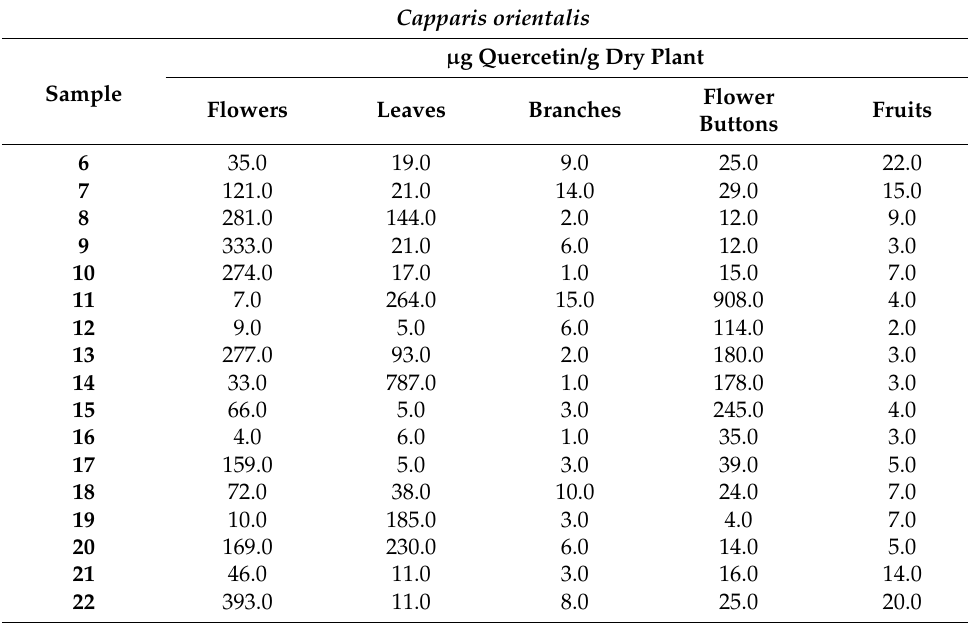
Table 4. Quercetin content ( µ g) in the epigean parts of C. orientalis